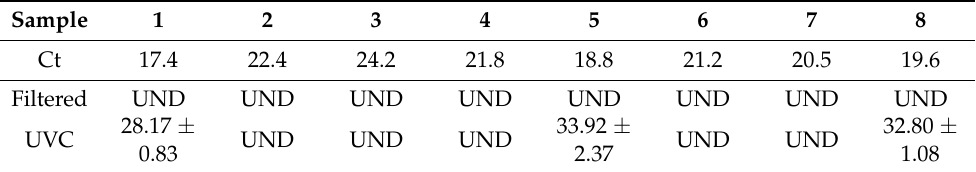
Table 1. PCR Amplification cycle threshold (Ct) values obtained from the N3 gene amplifica- tion of BAL specimens from SARS-CoV-2 positive patients treated with ultrafiltration or UVC. UND = Undetectable.